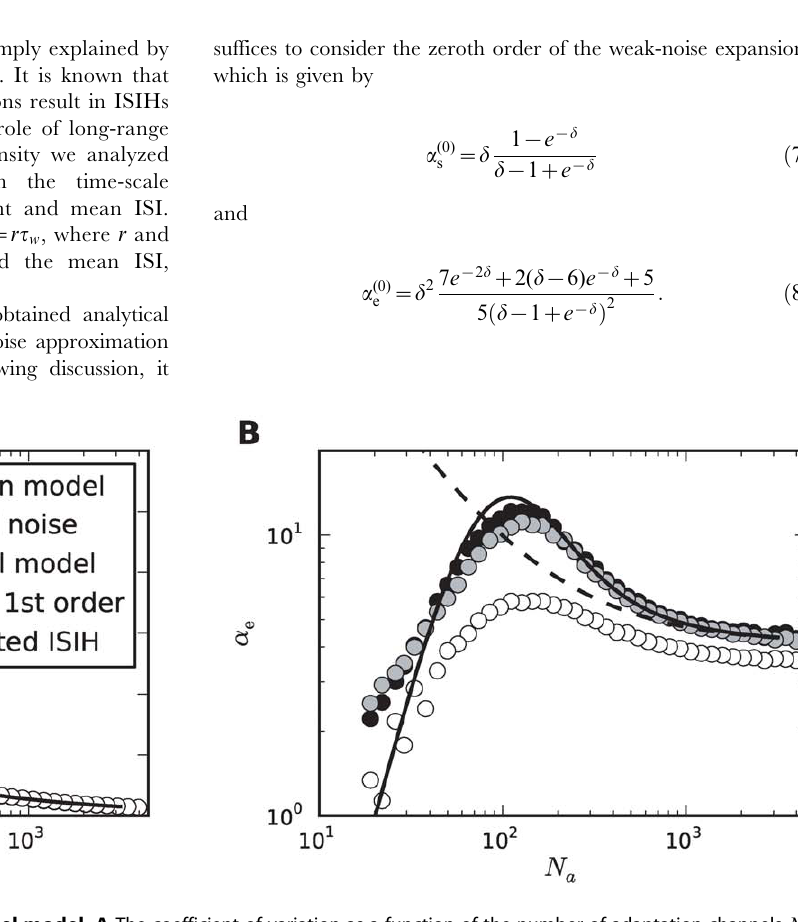
Figure 5. Shape parameters of the ISIH for deterministic and stochastic adaptation. A Rescaled skewness a s for deterministic adaptation (white squares) and for stochastic adaptation (channel model – white circles, diffusion model – black circles, colored noise approximation – gray circles). Different CVs were obtained by varying N a or D . The dashed line depicts the theoretical curve, Eq. (7), and the solid line depicts the semi- analytical result obtained from the moments of the ISI density, Eq. (69), using numerical integration. B The corresponding plot for the rescaled kurtosis a e . The adaptation time constant was t w ~ 100ms . All other parameters as in Fig. 2.